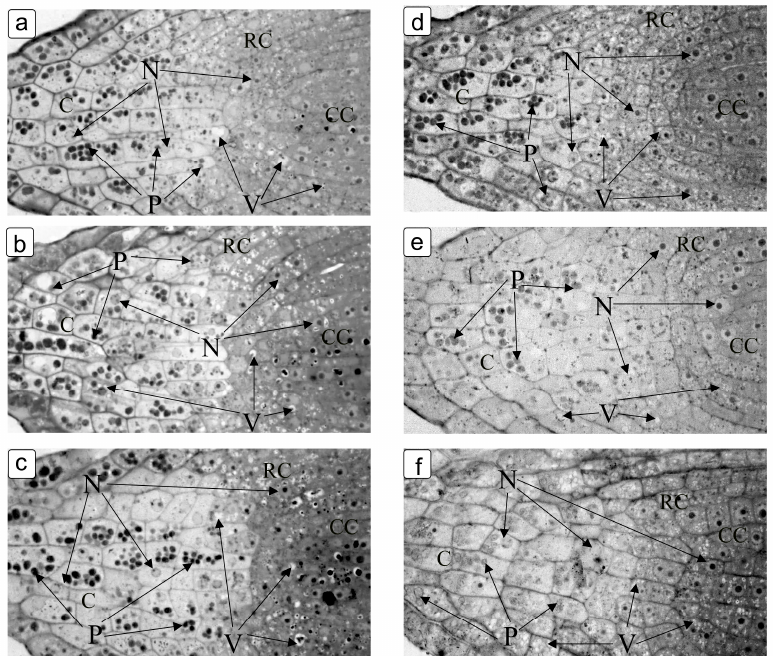
Figure 4. Longitudinal sections of tomato root in the YaLF line (( a ) 0 mM NaCl; ( b ) 75 mM NaCl; ( c ) 150 mM NaCl)) and cv Recordsmen (( d ) 0 mM NaCl; ( e ) 75 mM NaCl; ( f ) 150 mM NaCl)) under various concentrations of sodium chloride. Abbreviations: C—columella cells; RC—root cortex cell; CC—central cylinder cells; N—nucleus; P—plastid; V—vacuole. The images were taken at 30× objective magnification.